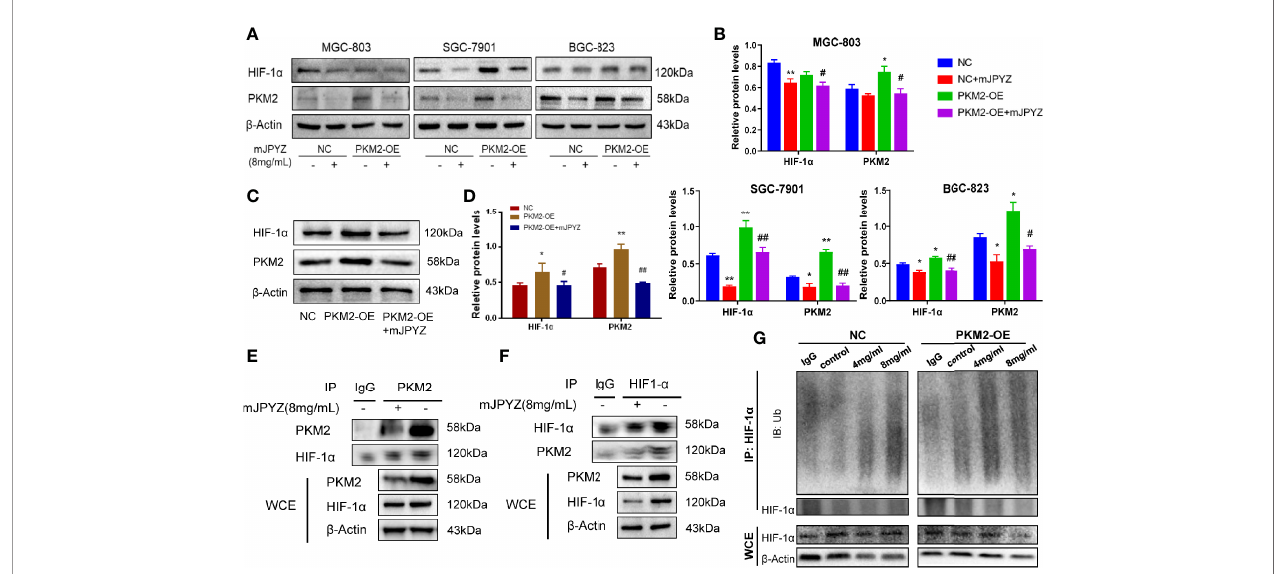
FIGURE 6 | mJPYZ impaired PKM2/HIF-1 a signaling pathway. (A – C) The effects of PKM2 overexpression on interacted HIF-1 a by western blotting. PKM2-OE induced increased PKM2 and HIF-1 a , while mJPYZ treatment decreased the expression of PKM2 and HIF-1 a whether in NC or PKM2-OE, compared with untreated control. (D) Western blotting showed mJPYZ treatment decreased the expression of PKM2 and HIF-1 a in vivo . (E, F) Co-IP analysis of the interaction between PKM2 and HIF1- a in gastric cancer cells. (G) mJPYZ treatment increased HIF-1 a ubiquitination degradation in a dose-dependently manner. Data are represented as mean ± SD, n=3 independent experiments. *P < 0.05, **P < 0.01 versus NC group, # P < 0.05, ## P < 0.01 versus PKM2-OE group by one-way analysis of variance (ANOVA) followed by Tukey ’ s post-hoc tests.